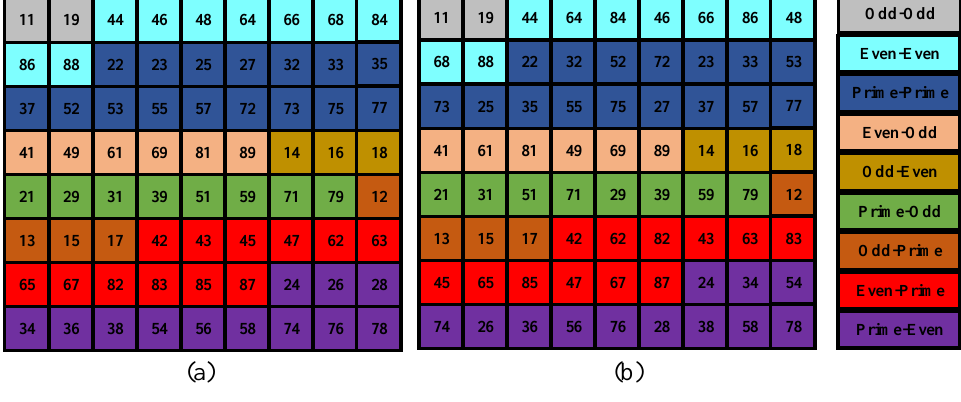
Figure 15. ( a ) OEP and ( b ) IOEP arrangement for 8 × 9 PV